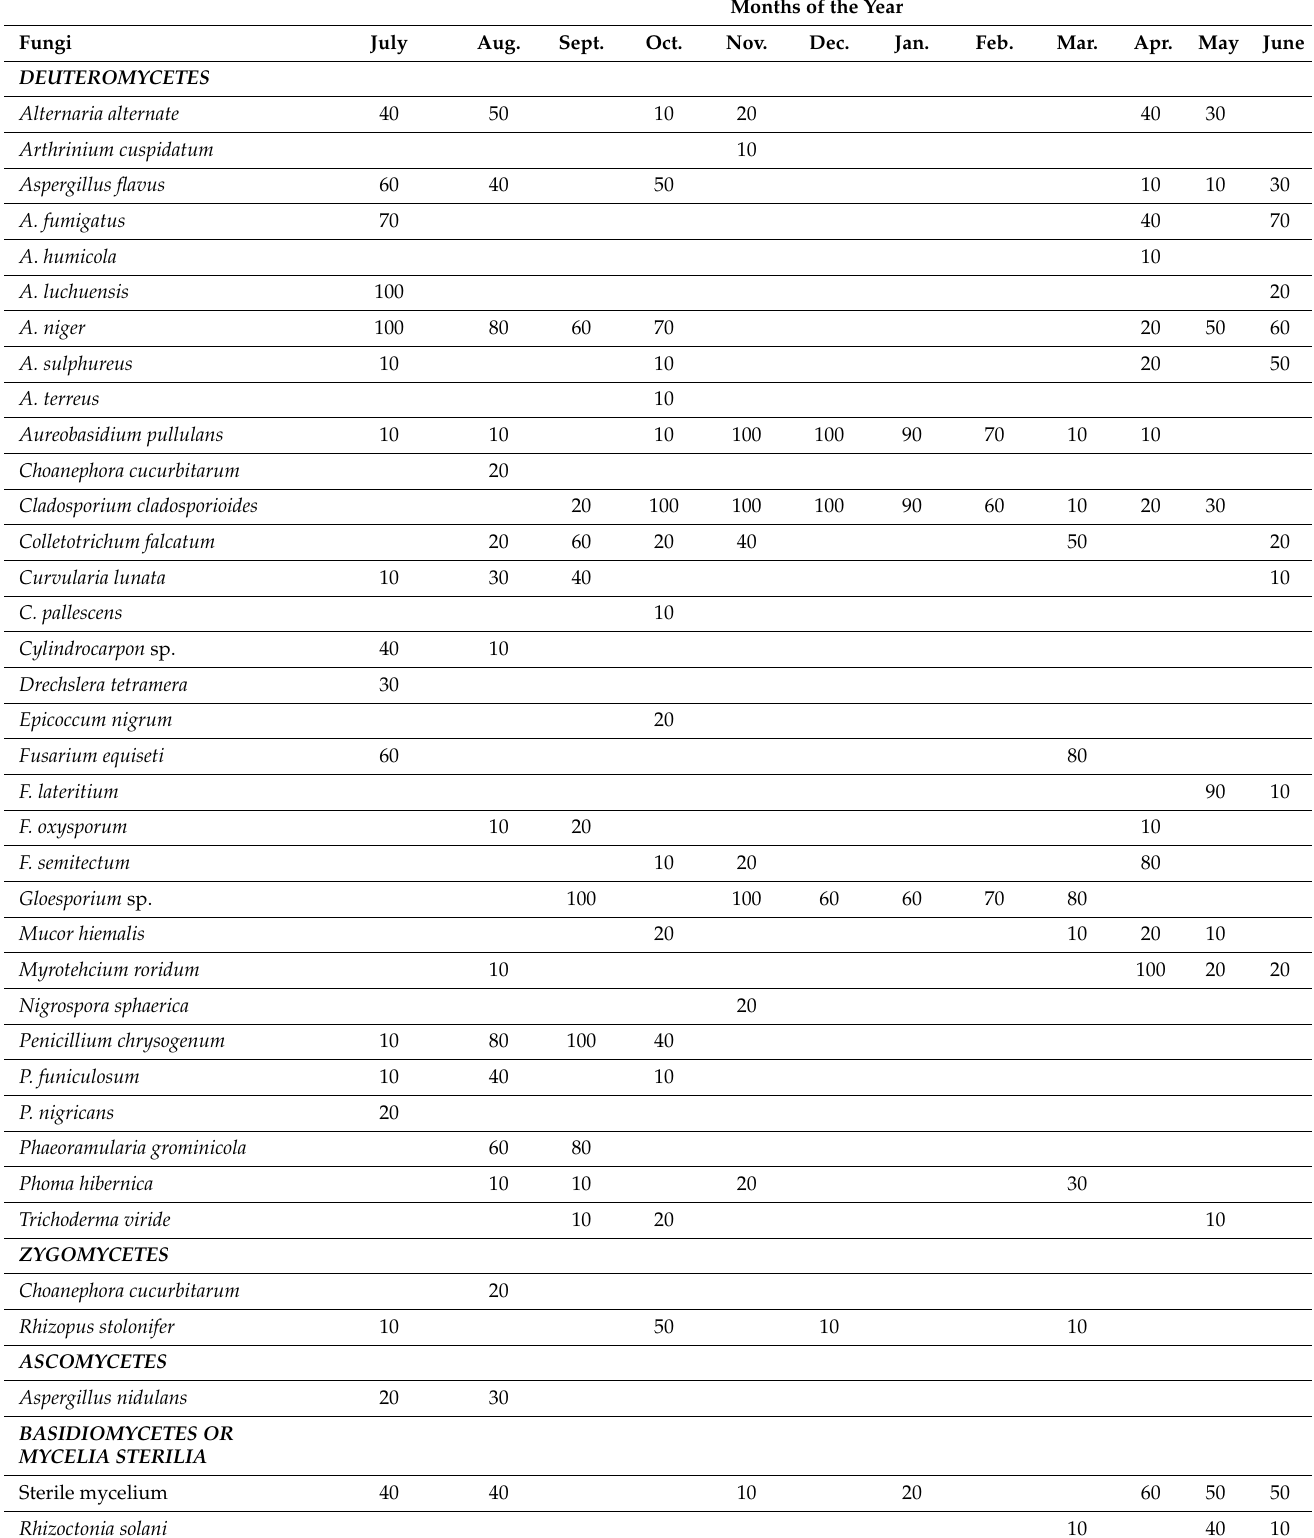
Table 4. Percentage frequency of occurrence of various fungi on yellow-Fallen leaves